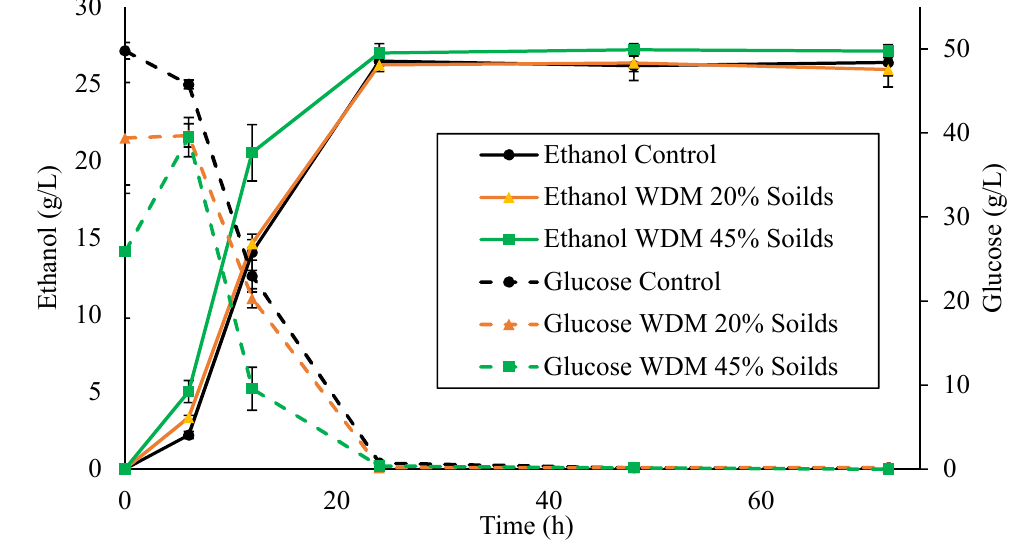
Figure 2. Ethanol and glucose profiles for fiber pretreated with disk milling and converted through SSF.